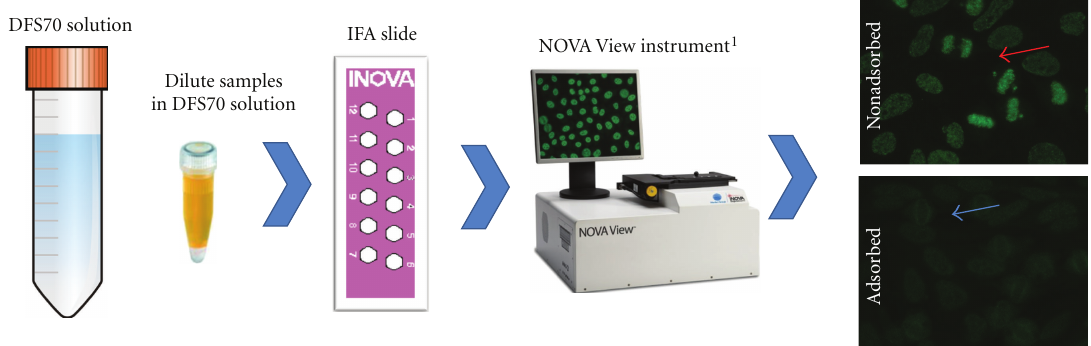
Figure 3: Immunoadsorption of anti-DFS70 antibodies. Serum samples are diluted in sample bu ff er containing recombinant DFS70 antigen and applied to HEp-2 cells on slides. Following immunodetection using a secondary antibody, indirect immunofluorescence is detected using NOVA View or a conventional microscope. Anti-DFS70 antibodies are specifically